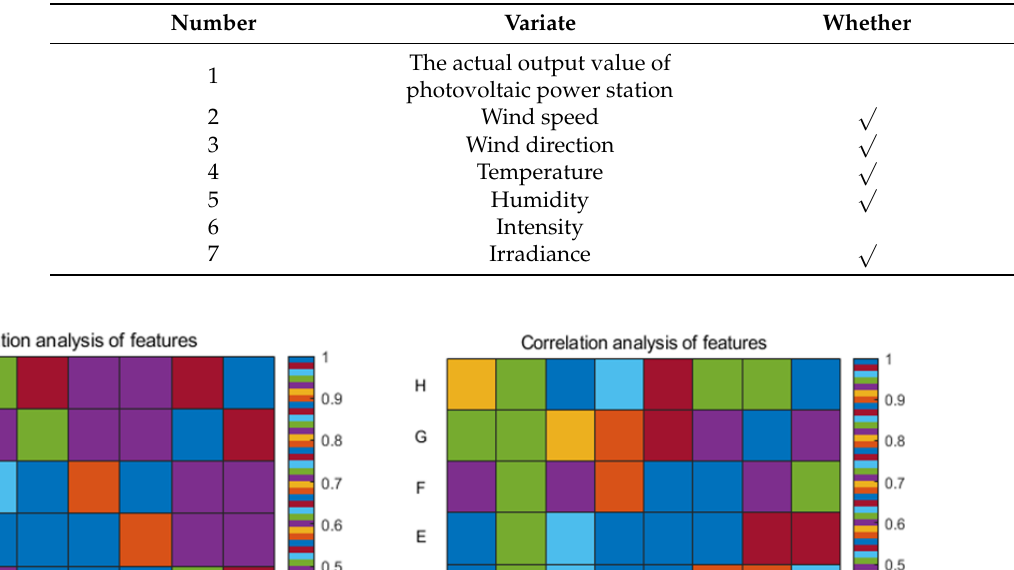
Figure 8. Schematic diagram for data set division. Table 1. Data composition of sample points.